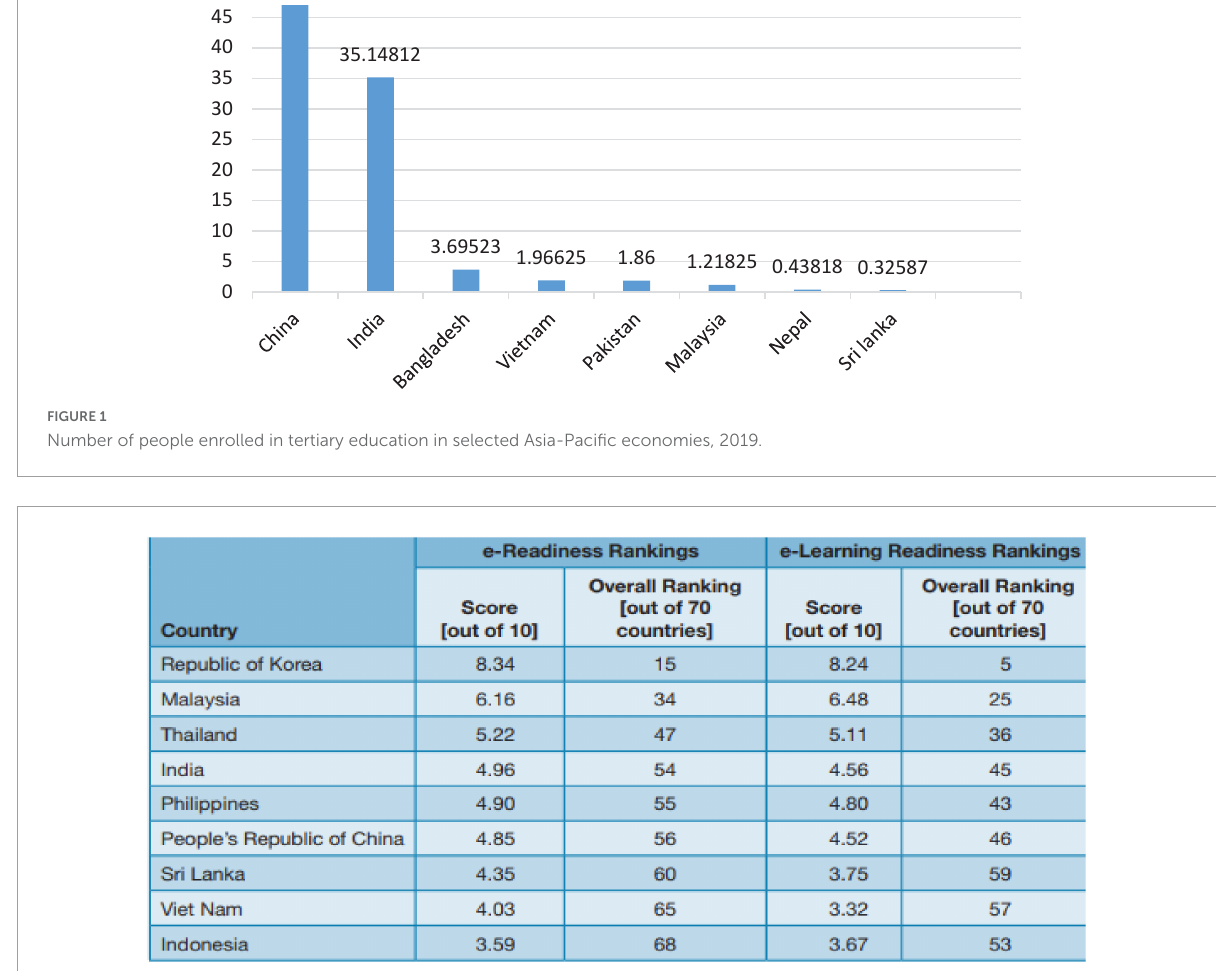
FIGURE2 Asian E-readiness rankings and E-learning readiness rankings. Source: Adapted from EIU (2003, 2008) as reported in Latchem and Jung